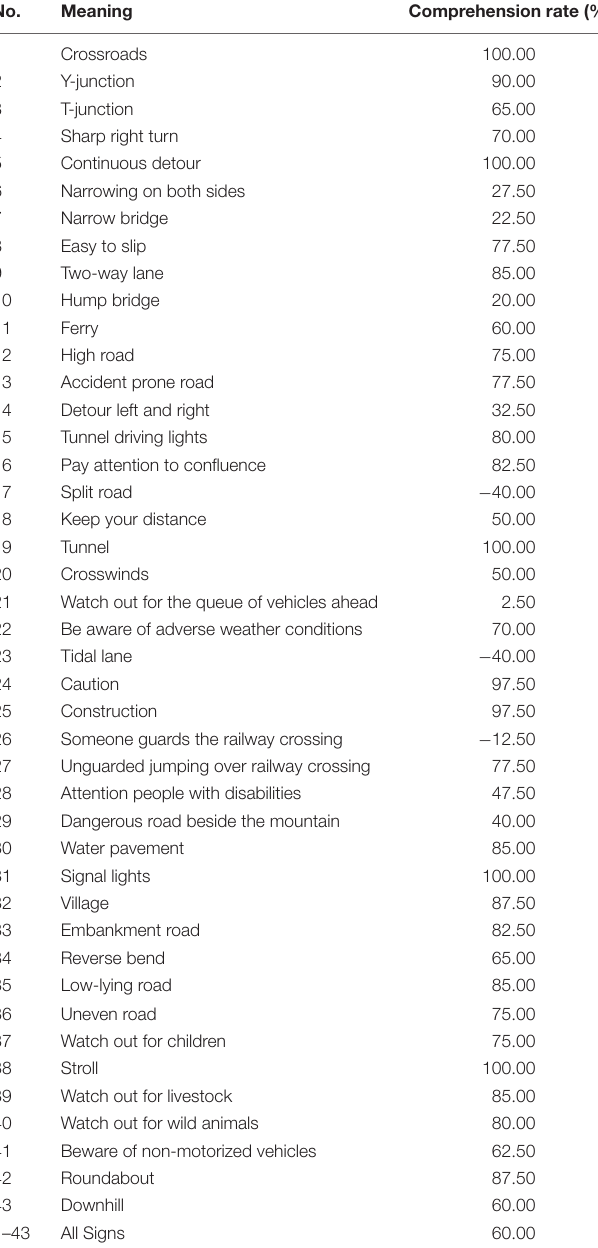
TABLE 2 | Descriptive statistics of the comprehension rate of 43